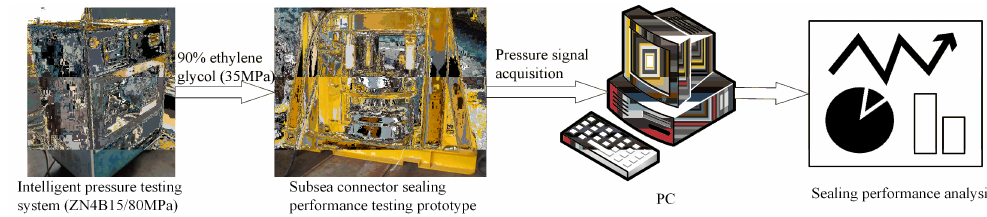
Figure 12. The test scheme using the engineering prototype.